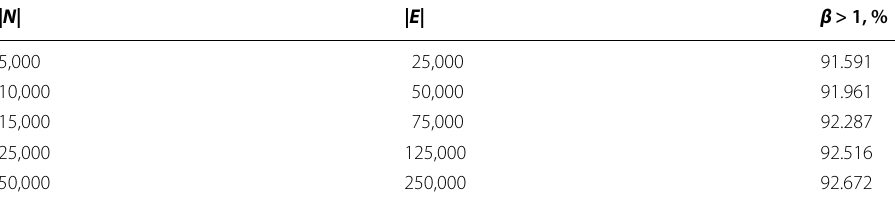
Table 2 Characteristics of friendship index distributions in synthetic networks generated with Barabási–Albert